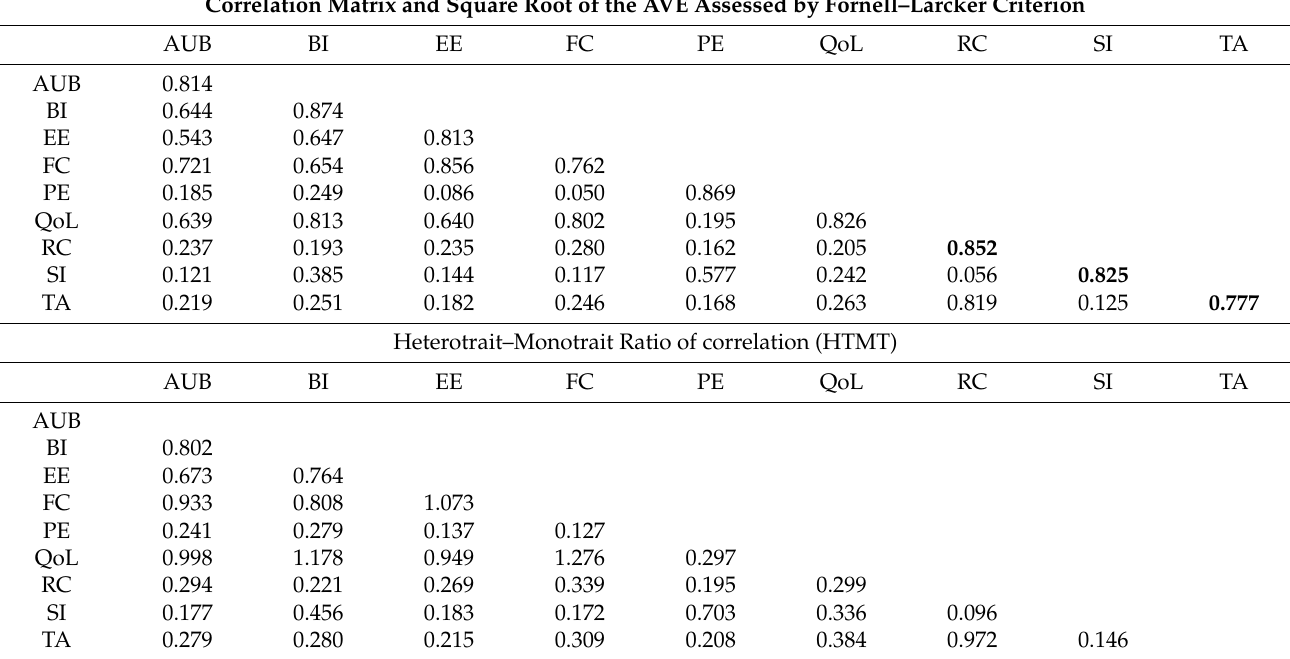
Table A3. Discriminant validity.